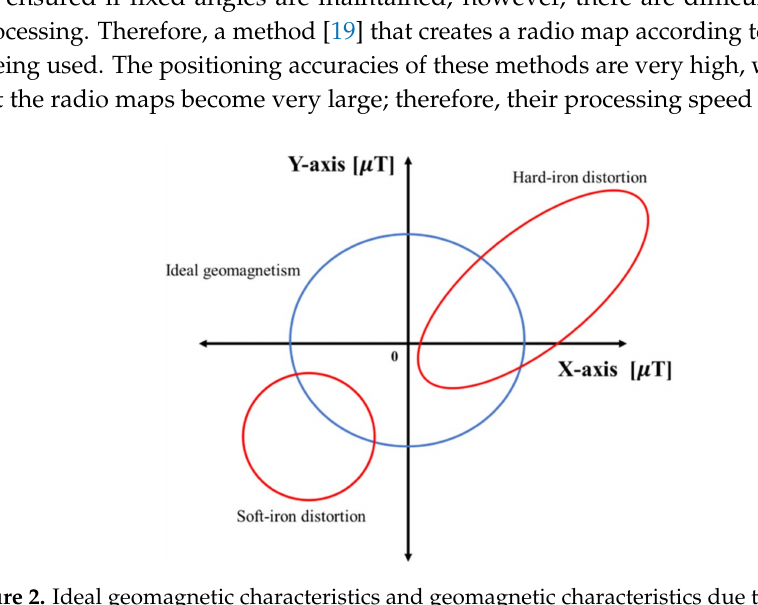
Figure 2. Ideal geomagnetic characteristics and geomagnetic characteristics due to distortion.